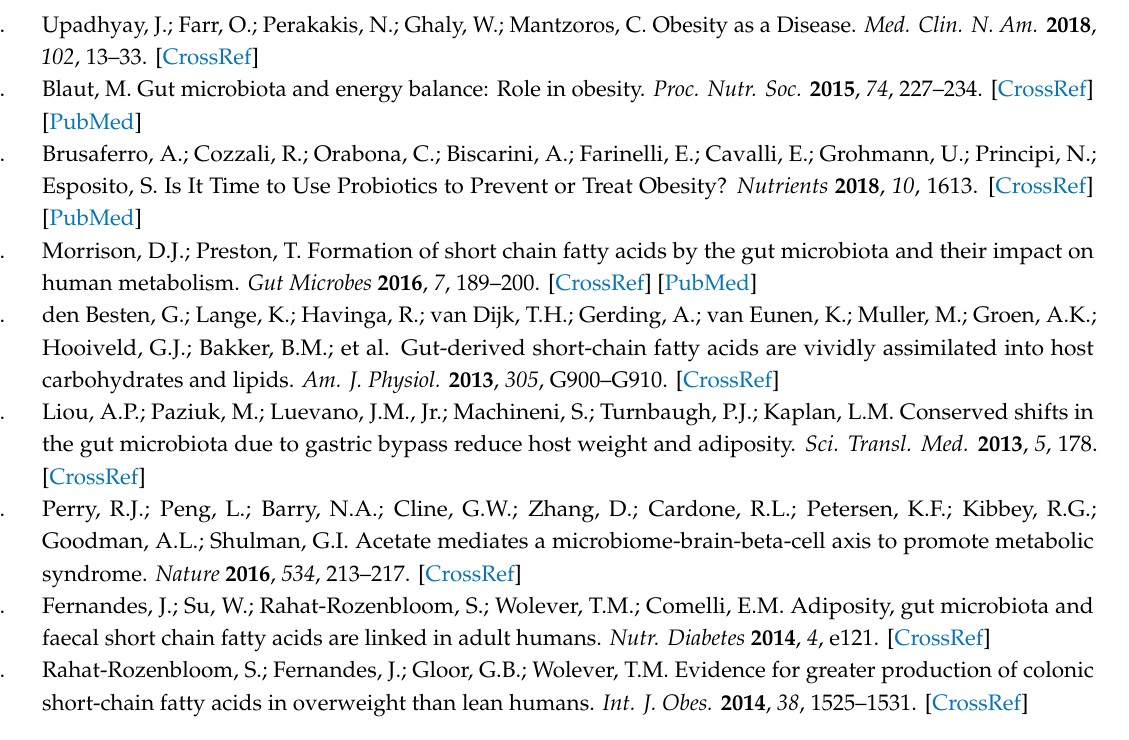
Figure S1: Sensitivity analysis for the meta-analysis of short chain fatty acid and obesity, Figure S2: Begg’s funnel plots with 95% confidence intervals for the meta-analysis of fecal microbiota, Table S1: Search strategy, Table S2: Reference list of papers excluded from the meta-analysis, Table S3: Quality scoring for included five articles using Newcastle–Ottawa scale (NOS) for case-control studies, Table S4: Summary of studies included in the analysis of fecal microbiota levels in obese and nonobese subjects, Table S5: Grade quality of evidence summary of the included